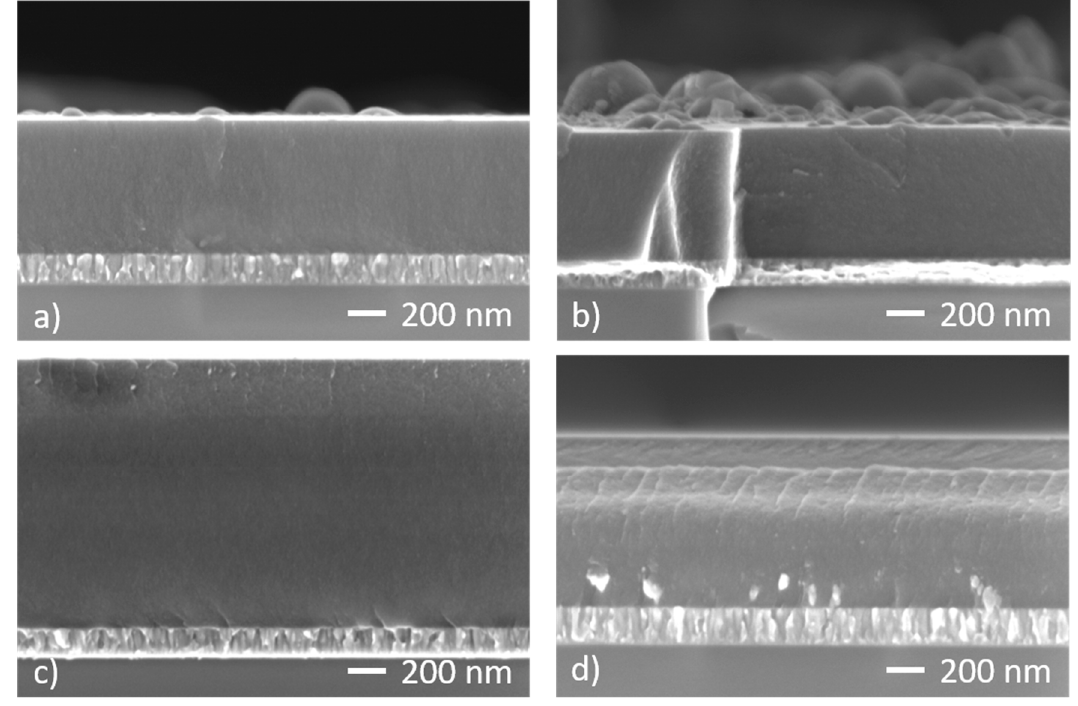
Figure 5. Typical cross section SEM on of coatings on Si substrates obtained in different gas atmospheres: ( a ) Ar, ( b )Ar/Ne, ( c ) Ar/C 2 H 2 , ( d ) Ar/Ne/C 2 H 2.